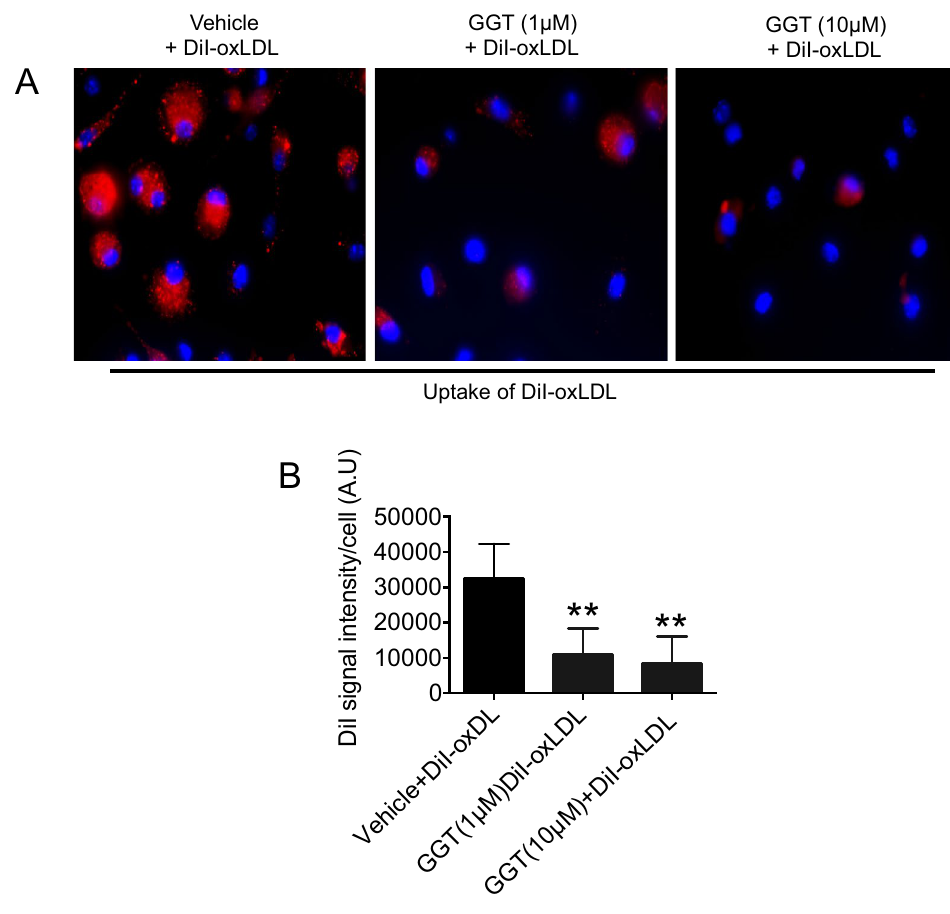
Figure 6. Ginkgetin blocks DiI-oxLDL uptake in macrophages. Macrophages were pretreated with vehicle or two doses of ginkgetin (1 or 10 µM) for 3 h followed by incubation with DiI-labeled oxLDL (2.5 µg/mL) for 30 min at 37 °C. ( A ) Representative images of DiI-oxLDL from ten different fields per condition (original magnification, 40×) are shown. DiI-oxLDL uptake indicated by red fluorescence. ( B ) Bar graphs show mean DiI fluorescence intensity (mean ± SEM) analyzed using NIH ImageJ software. ** p < 0.01 for oxLDL uptake in untreated versus ginkgetin treated cells; n = 50